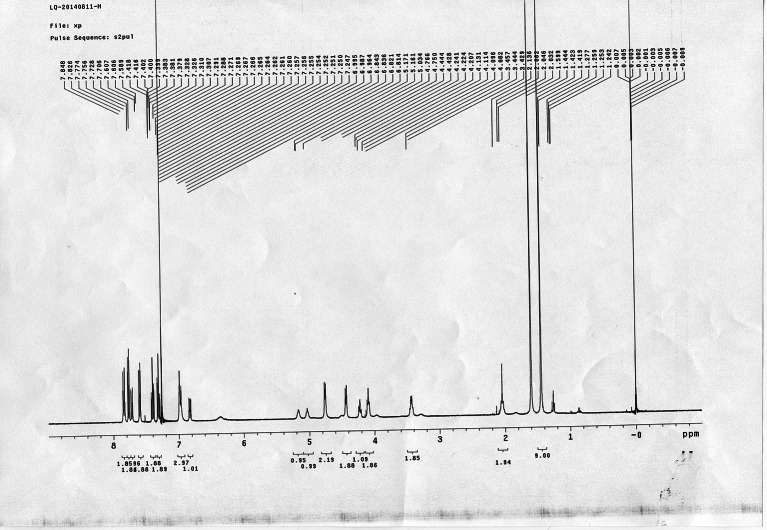
1H NMR spectra of compound 22.